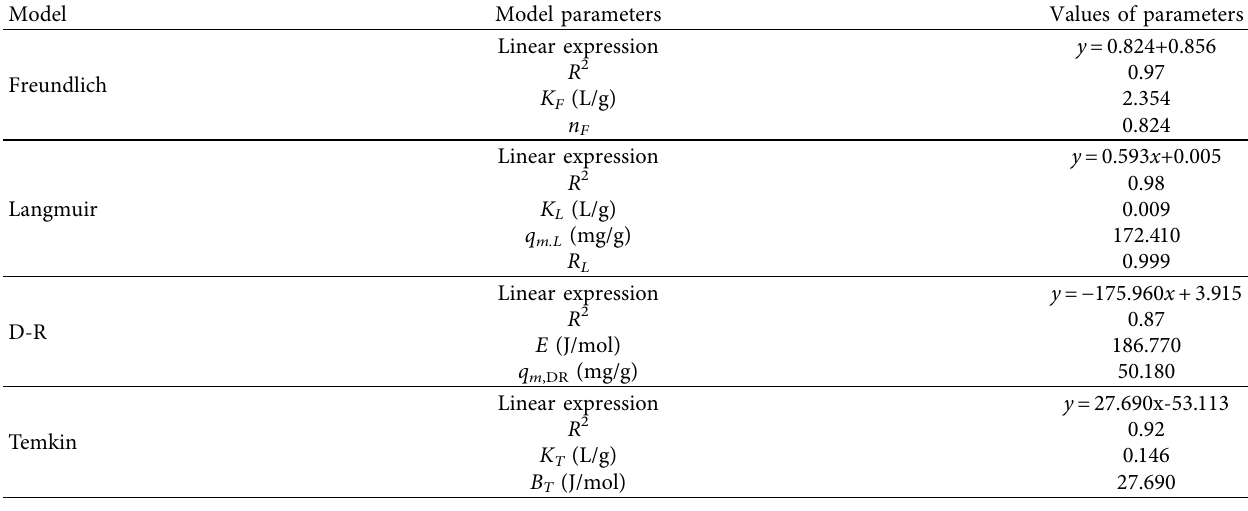
Table 3: Adsorption isotherms models parameter at pH 2 for Cr(VI) adsorption by WM. Model